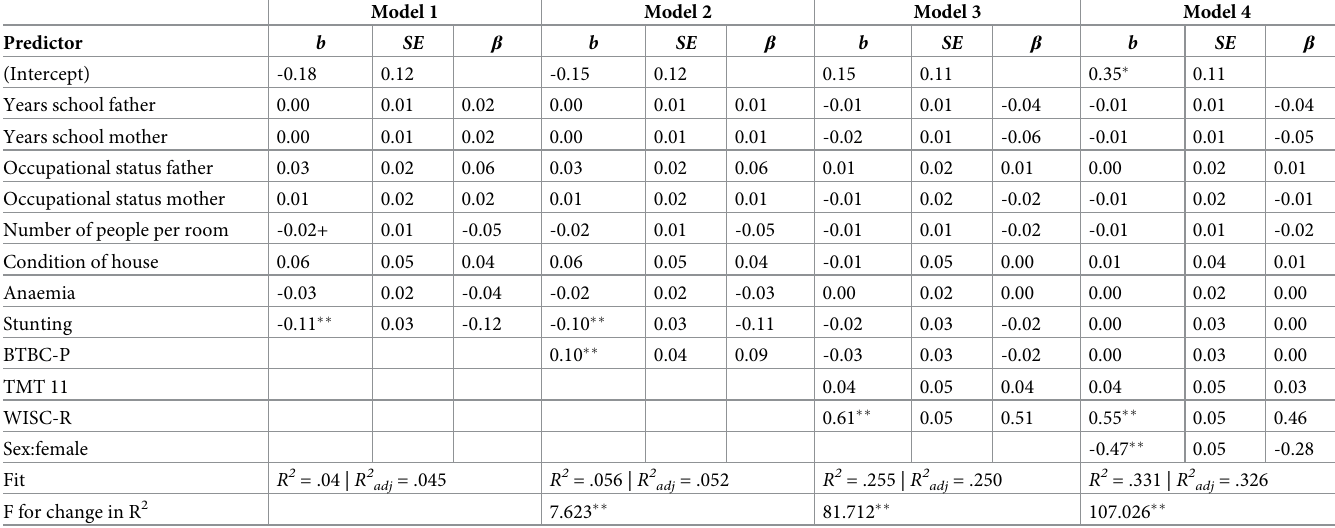
Table 6. Regression results for performance on the Perceptual Maze Test at age 17 years predicted by early childhood risk factors (age 3 years) as well as cognitive functioning at ages 3 and 11 years and sex based on imputed